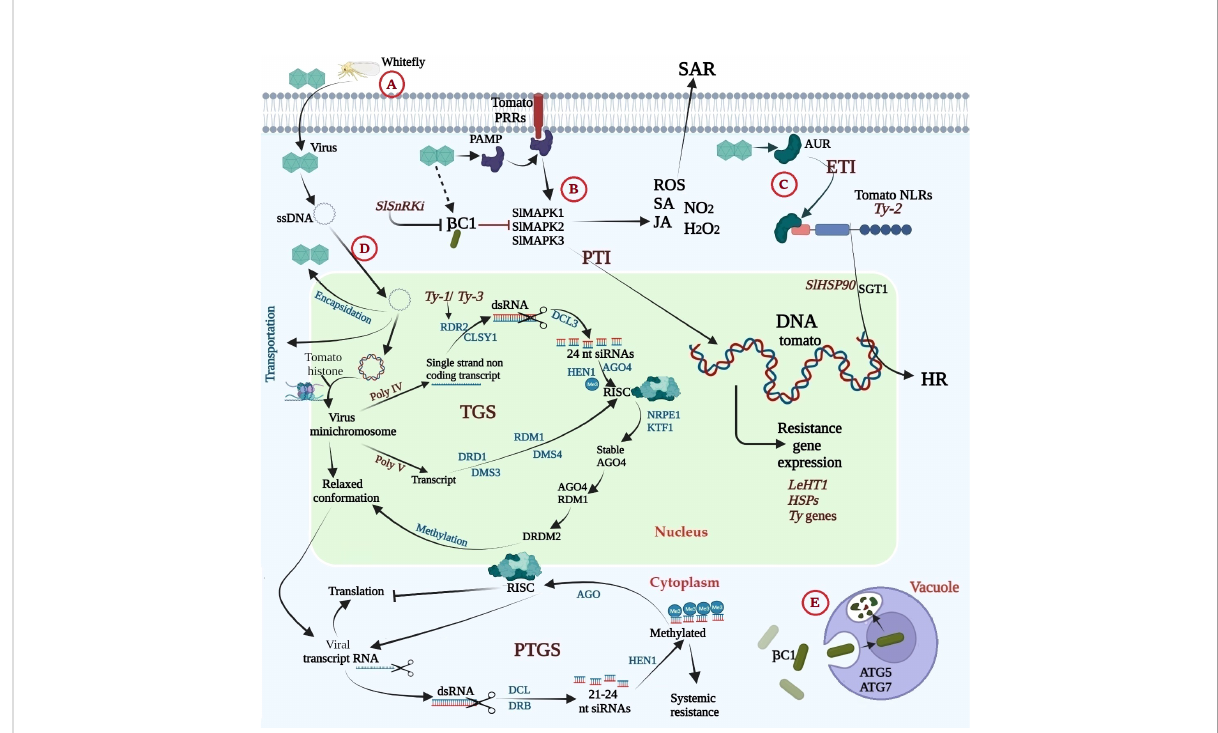
FIGURE 5 Molecular response of tomato during TYLCV infection; (A) the white fl y carries the virus and transfer it to the tomato during its feeding, (B) the tomato ’ s fi rst line of defense is recognition of pathogen-associated molecular patterns (PAMP) by host pattern recognition receptors (PRRs), resulting in activation of PAMP triggered immunity (PTI), (C) the tomato second line of defense, plants have evolved cytoplasmic R proteins (nucleotide binding – leucine-rich repeat proteins, NB-LRR) (NLRs) i.e., Ty-2 gene that recognizes the presence or activity of speci fi c virus effectors like avirulence AVR, resulting in effector triggered immunity (ETI), (D) Once the viral ssDNA is released from the capsid, it enters the cytoplasm of the infected cell and subsequently enters the cell nucleus, where it undergoes rolling-circle and recombination dependent replication and plant immunity begin by inducing both TGS and PTGS, with the help of Ty-1 / Ty-3 genes, (E) Tomato autophagy, where Rep protein of TLCYnV, CLCuMuB b C1 protein interacts with autophagy related protein NbATG8 through its ATG8 interacting motif (LVSTKSPSLIK) and directs it for degradation. This fi gure was made using